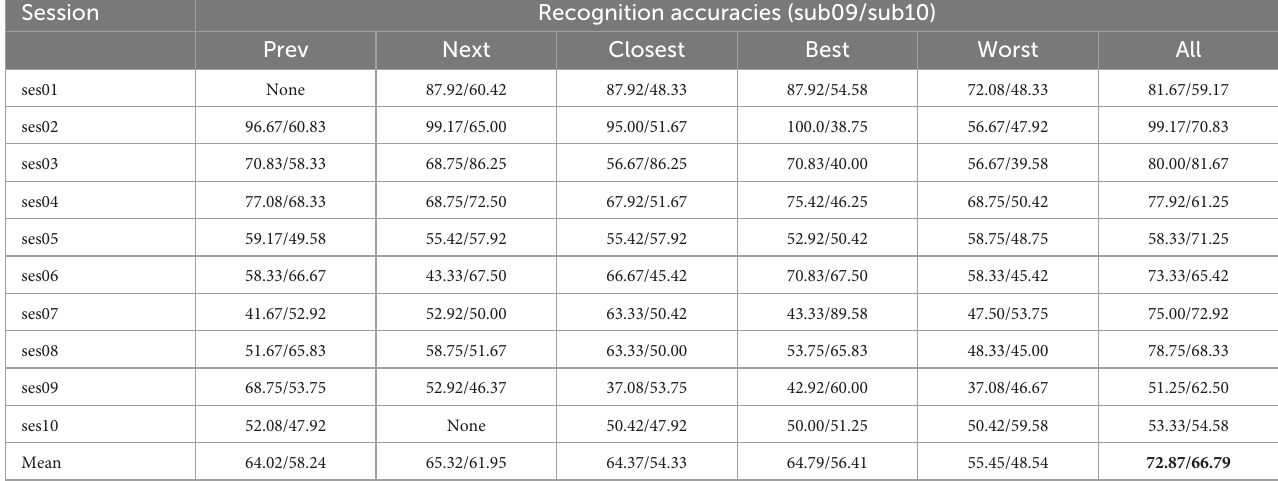
TABLE 3 The performance of the different strategies in the cross-session test in Exp2. Session Recognition accuracies (sub09/sub10) Prev Next Closest Best Worst All ses01